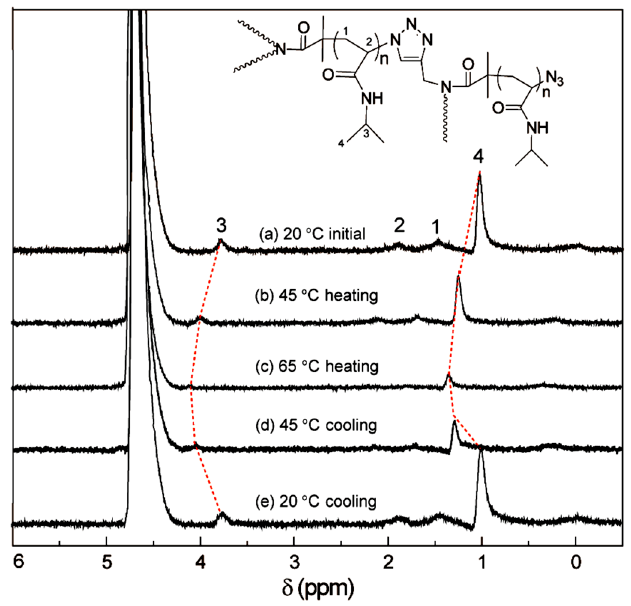
Figure 4. 1 H NMR spectra of LCHBPNIPAM self-assemblies in D 2 O at ( a ) 20 °C; ( b ) 45 °C (heating); ( c ) 60 °C (heating); ( d ) 45 °C (cooling); ( e ) 20 °C (cooling).